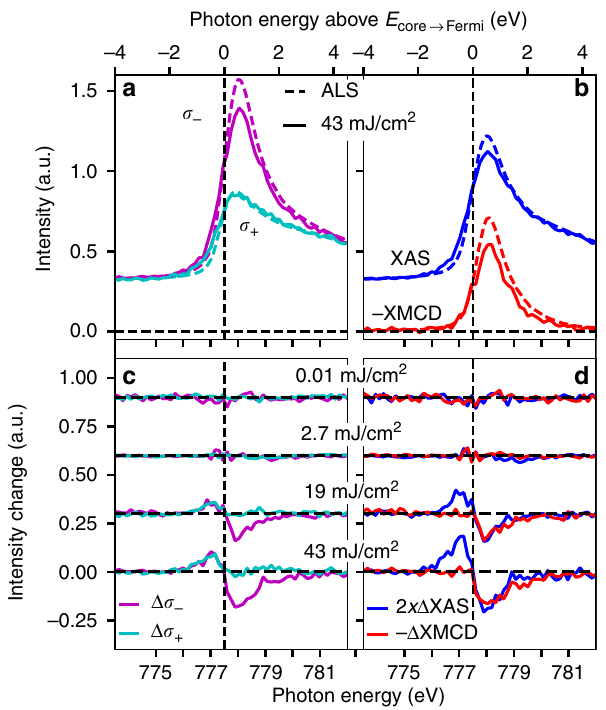
Fig. 2 Dependence of X-ray absorption on incident X-ray fl uence. Absorption spectra were recorded in the low fl uence limit at the Advanced Light Source (ALS) synchrotron light source, and with variable incident X- ray fl uence at the Linac Coherent Light Source (LCLS). The spectra are shown in their original recorded forms with parallel ( σ (cid:3) ) and anti-parallel ( σ þ ) orientations of X-ray polarization with respect to sample magnetization a, c in addition to forms derived from these b , d . In parts b and d , XAS is the X-ray Absorption Spectrum found by averaging the σ σ (cid:3) and þ spectra, while XMCD is the X-ray Magnetic Circular Dichroism spectrum found by subtracting the σ (cid:3) spectrum from the σ þ spectrum. The correct photon energy for exciting Co 2p 3 = 2 core electrons into unoccupied states at the Fermi level was estimated as the zero crossing of the fl uence- dependent XAS changes. This photon energy is indicated with dashed vertical lines and labeled E . a X-ray absorption spectra recorded core ! Fermi with parallel ( σ (cid:3) ) and anti-parallel ( σ þ ) orientations of X-ray polarization and sample magnetization. b XAS and XMCD spectra calculated from the data shown in a . c Difference of X-ray absorption spectra recorded at varying incident X-ray fl uence at LCLS relative to those recorded in the low fl uence limit. d Difference of XAS and XMCD recorded with varying incident X-ray fl uence at LCLS relative to the low fl uence limit. Source data provided as a Source Data fi